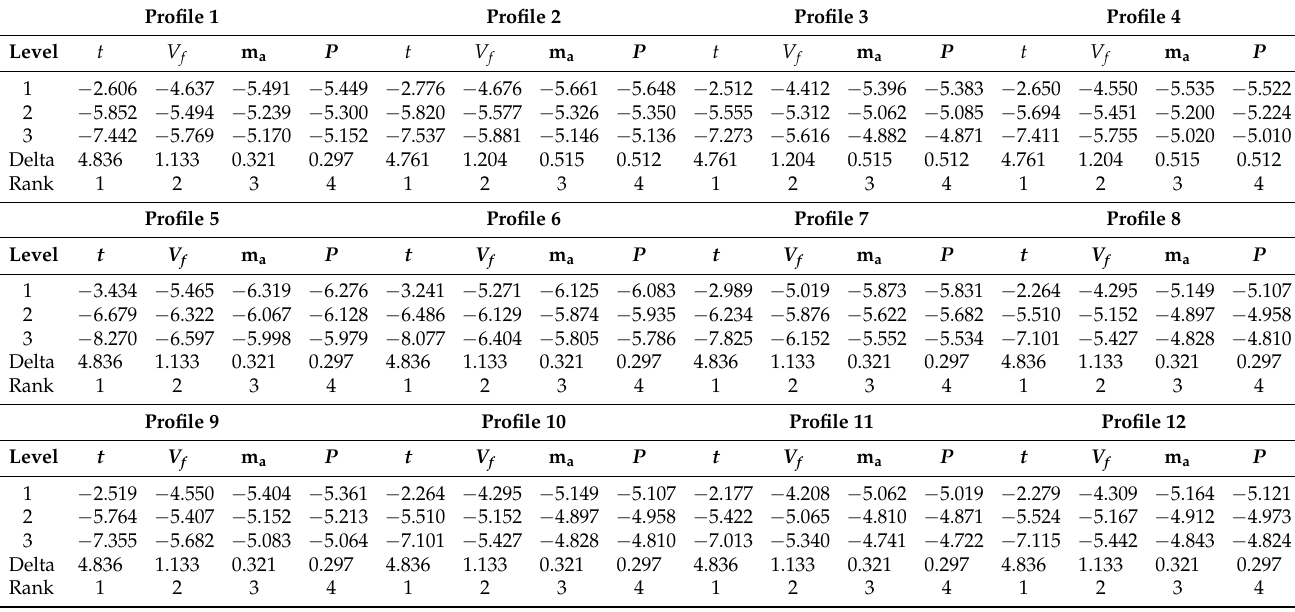
Table A3. Average response table for signal-to-noise ratios for surface roughness (smaller is better). Profile 1